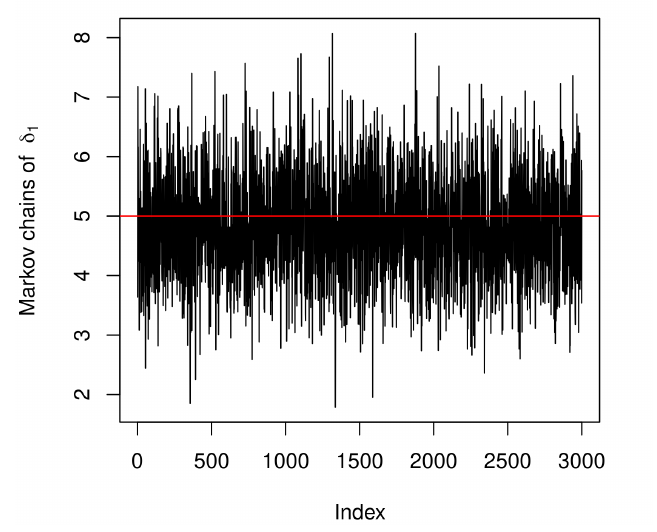
Figure 2. The Markov chains of δ 1 . The horizontal line is the true value of δ 1 .